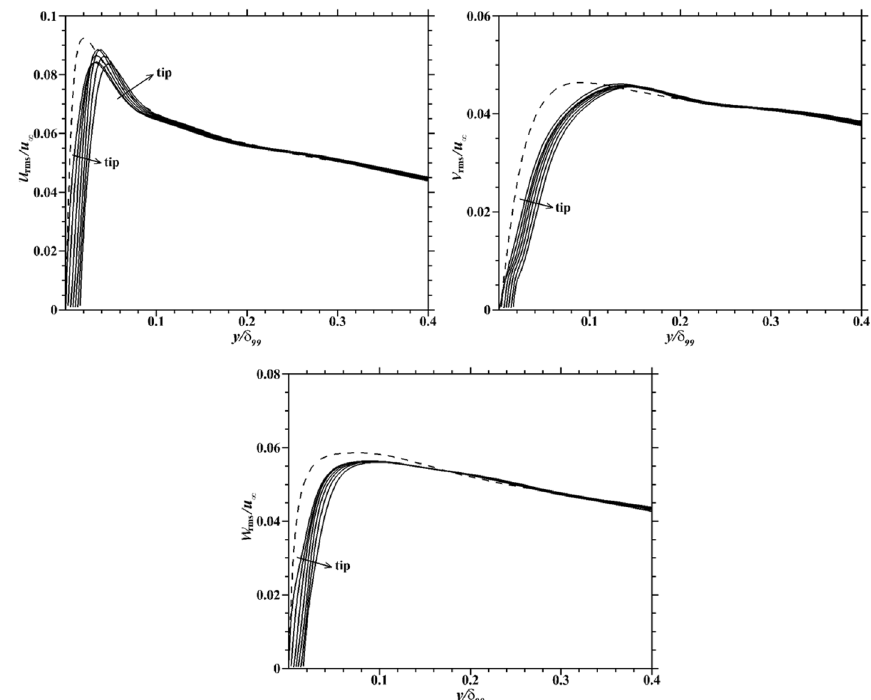
Fig. 13 Wall turbulence fluctuation Root Mean Square (RMS) distribution. (The dashed line indicates the result of the smooth flat-plate case, and the arrow marks the position from the valley to the tip of